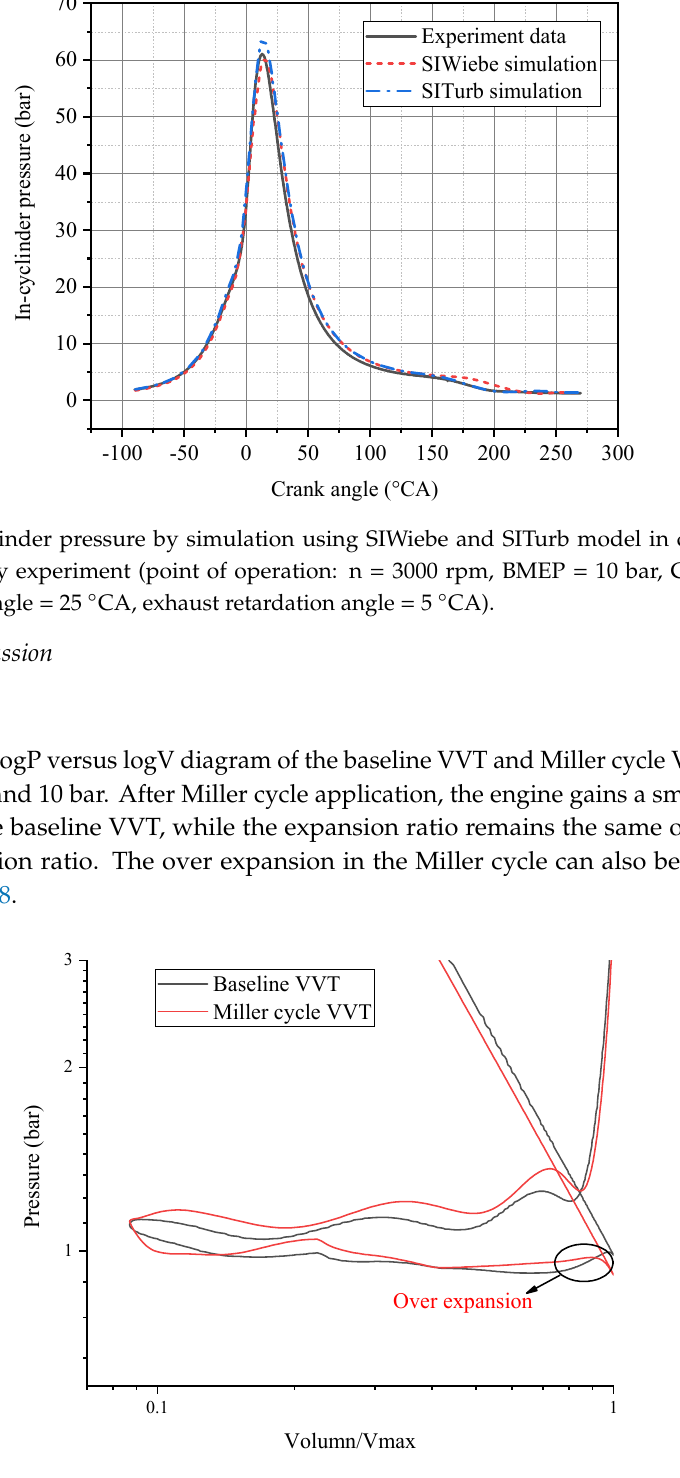
Figure 16. Heat release rate by simulation using SIWiebe and SITurb models in comparison of measured data by experiment (point of operation: n = 3000 rpm, BMEP = 10 bar, CA50 = 8 °CA, intake advance angle = 25 °CA, exhaust retardation angle = 5 °CA).